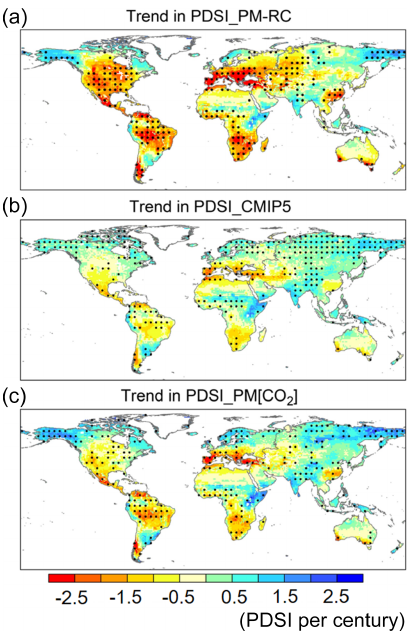
Figure 3. Global spatial pattern of PDSI trends. Spatial distri- bution of PDSI trends during 1901–2100 for (a) PDSI_PM-RC, (b) PDSI_CMIP5, and (c) PDSI_PM[CO 2 ], respectively. Black dots represent locations where the same sign of the PDSI trend is iden- tified in at least 13 out of the 16 CMIP5 models (i.e., > 80% of